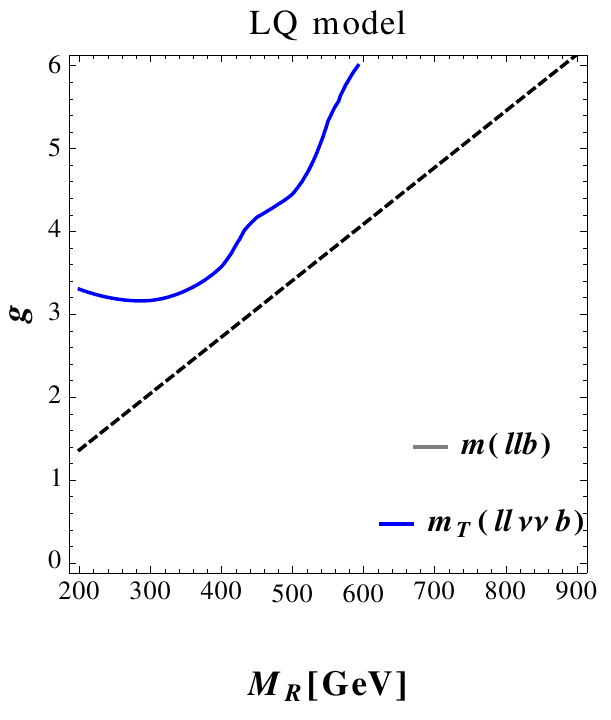
Figure 7 . 95% CL bounds in the M R vs g plane obtained by using the m T ( ll(cid:23)(cid:23)b ) (blue curve) di(cid:11)erential distribution measurement at 36.1 fb (cid:0) 1 . The limit obtained from m ( ‘‘b ) is o(cid:11) the edge of the plot. The dashed black line represnts the EFT bound of eq. (5.4). m di(cid:11)erential distribution) which corresponds to a straight line. In accordance with T